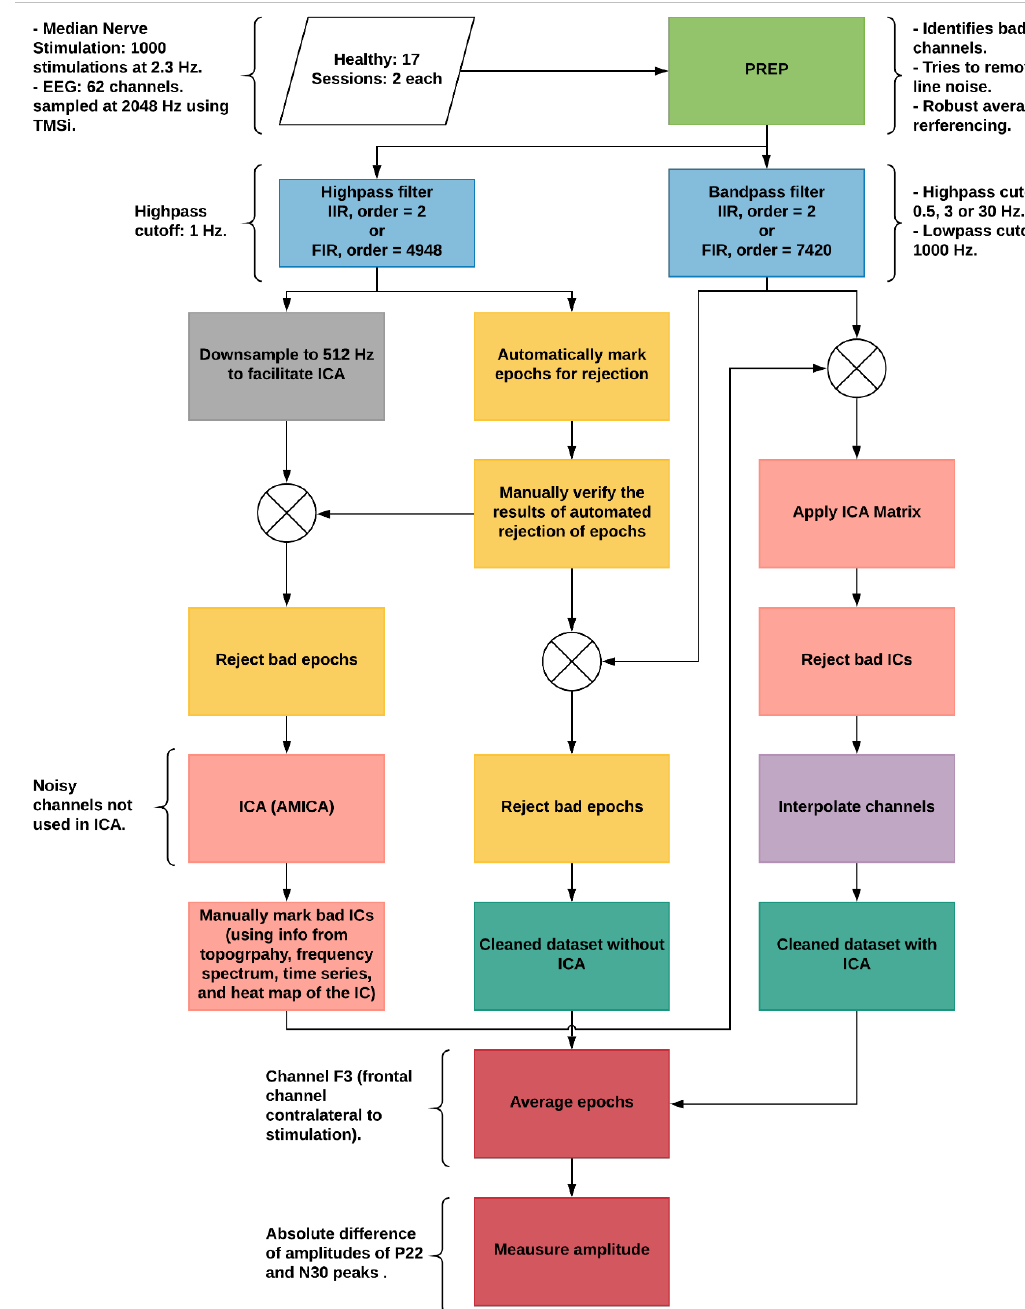
Figure 1. Methodology overview. The colors group similar processes or sub-processes. Blue is filter properties, yellow corresponds to artifact detection and rejection, salmon pink represents steps related to independent component analysis (ICA), dark green are cleaned datasets, and red are related to somatosensory evoked potential (SEP) averaging and amplitude. Abbreviations: FIR = Finite Impulse Response; IIR = Infinite Impulse Response; AMICA = adaptive mixture ICA; IC = Independent Component.